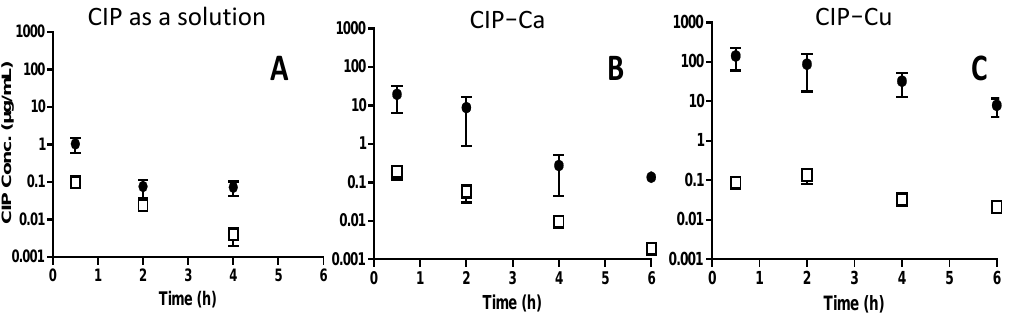
Figure 2. CIP concentration profile in the lung epithelial lining fluid (ELF) (plain dot) and free CIP plasma concentration profile (open square) obtained after IT administration to rats of ( A ) a CIP solution, ( B ) particles loaded with the CIP–Ca low-affinity complex, or ( C ) particles loaded with the high-affinity CIP–Cu complex. The CIP dose was 3 mg/kg. Each point is an averaged value ± standard deviation (SD) of 4–7 individual measurements (adapted from Lamy et al. [22]).